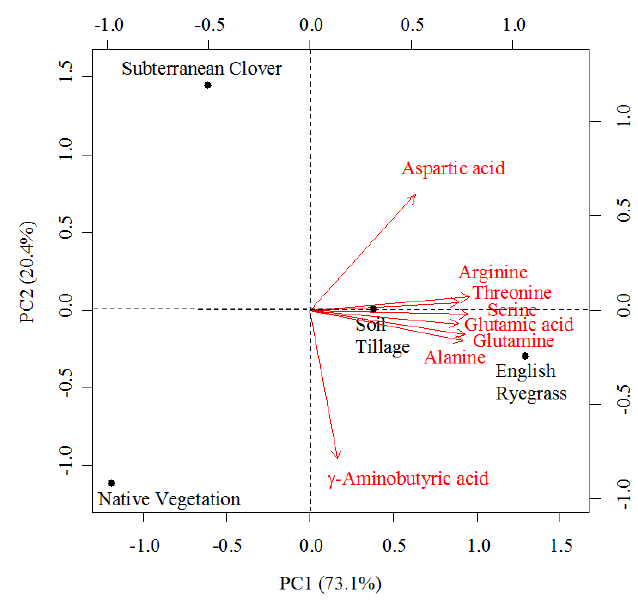
Figure 3. Principal component analysis (PCA) of Mencía musts: Biplot for the first two components (PC) for the eight most abundant amino acids in musts.